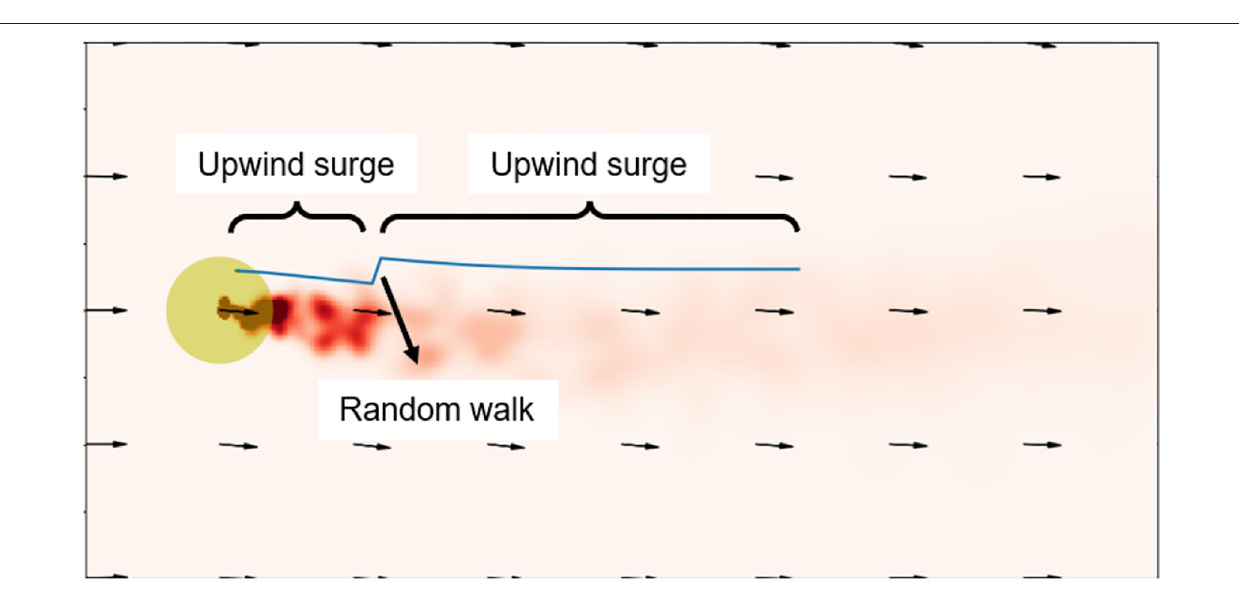
FIGURE 6 | A typical odor source searching trajectory with the MCOTSK model trained with the proposed successive training framework. The blue curves represent the